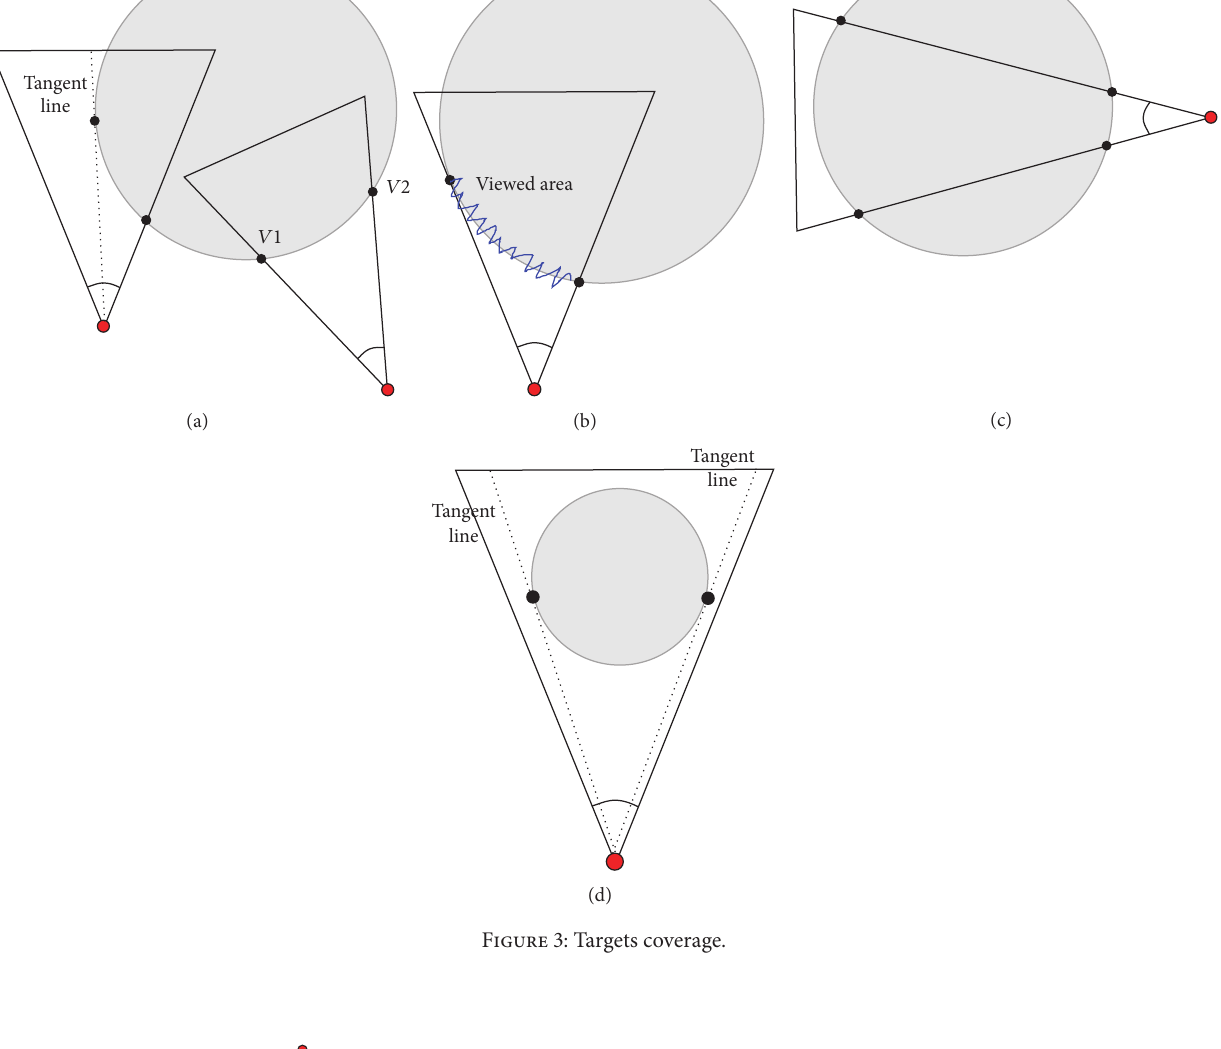
Figure 3: Targets coverage.